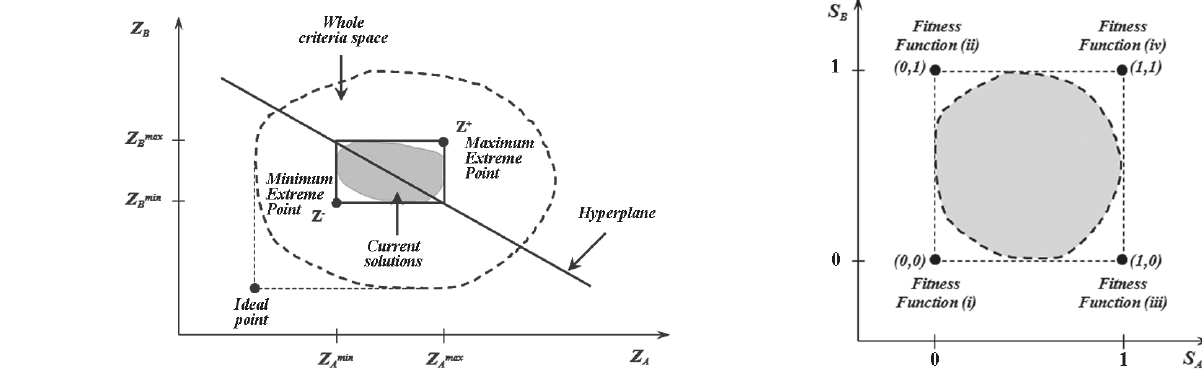
Fig. 5. Concept of the four types of fitness functionsFig. 4. Two extreme points and the